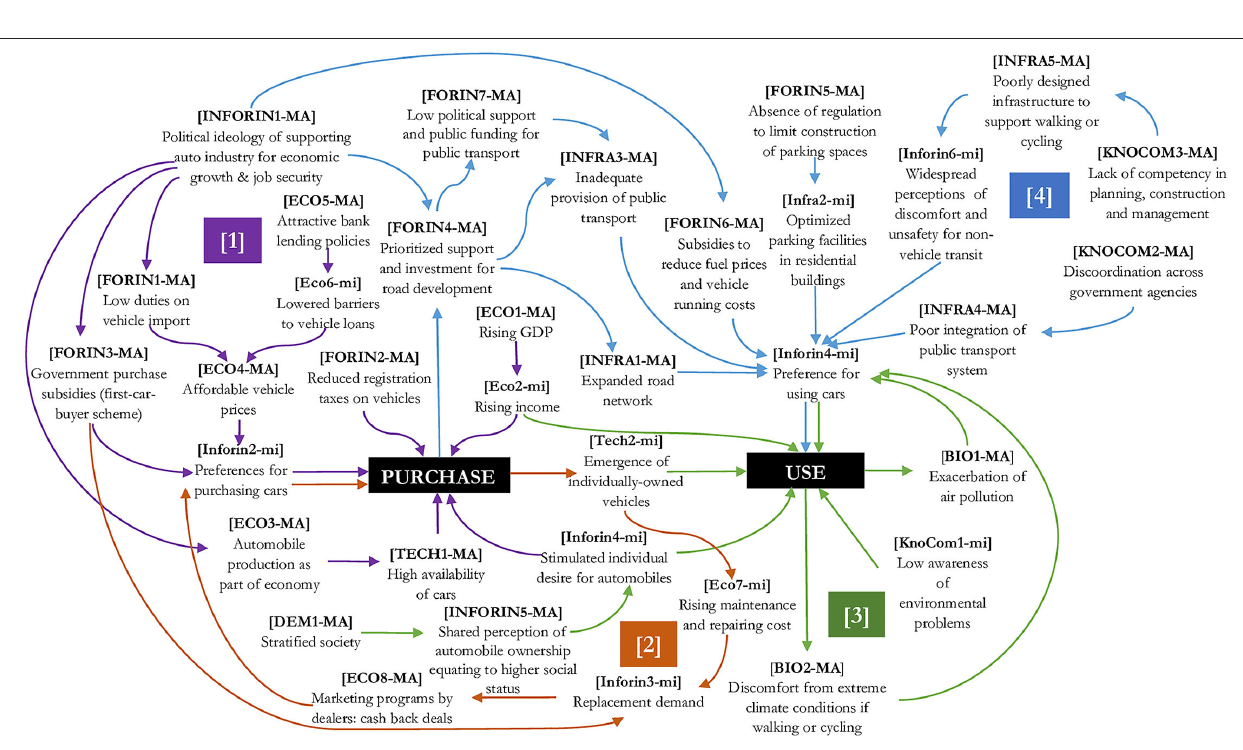
Asia” (Wad, 2009; Wonglimpiyarat, 2016) owing to its success at attracting foreign automobile brands, mainly Japanese, to build factories on the outskirts of Bangkok (Warr and Kohpaiboon, 2017). Thus, compared to the populations of other ASEAN countries, Thai people benefit from low purchase costs for new